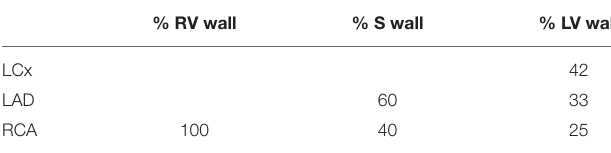
TABLE 1 | Volume distribution based on myocardial weight and coronary territory.